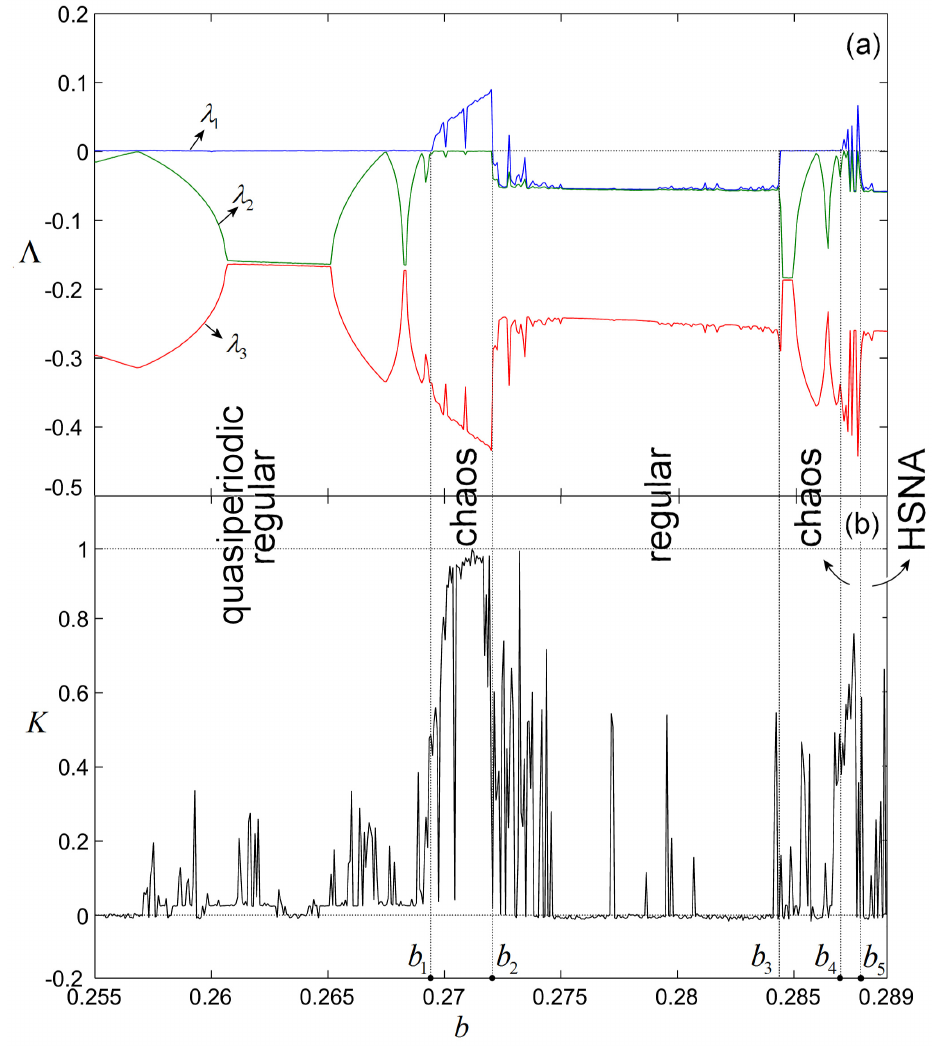
Figure 9. ( a ) LEs of the RF system for b ∈ [ 0.255,0.289 ] ; ( b ) median K for b ∈ [ 0.255,0.289 ]